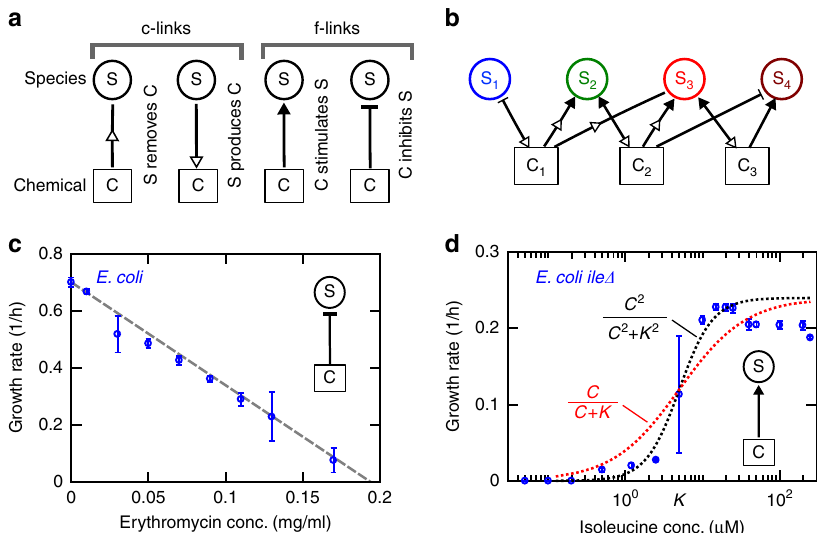
Fig. 1 By explicitly incorporating the chemicals, we simulate a community of microbes engaged in chemical-mediated interactions. a Community networks are de fi ned by two types of links: c-links (chemical production/removal links) indicated by hollow arrowheads and f-links (growth rate in fl uences on species) indicated either by fi lled arrows for facilitation or bar-termination for inhibition. b A combination of c-links and f-links represents a community of species interacting through chemical mediators. c Inhibitory chemicals are assumed to linearly decrease the growth rate of species (see Methods), motivated by experimental measurements of growth in the presence of antibiotics and metabolic byproducts (Supplementary Fig. 1). d The in fl uence of a facilitative chemical compound on species is approximated by the Monod equation for simplicity. Experimental observations of auxotrophic E. coli K-12 strains suggest that a second-order Moser equation (black dotted line; see Methods) offers a more accurate estimation (Supplementary Fig. 2), but the Monod equation (red dotted curve) is still an acceptable approximation. Error bars show s.d. based on 6 technical